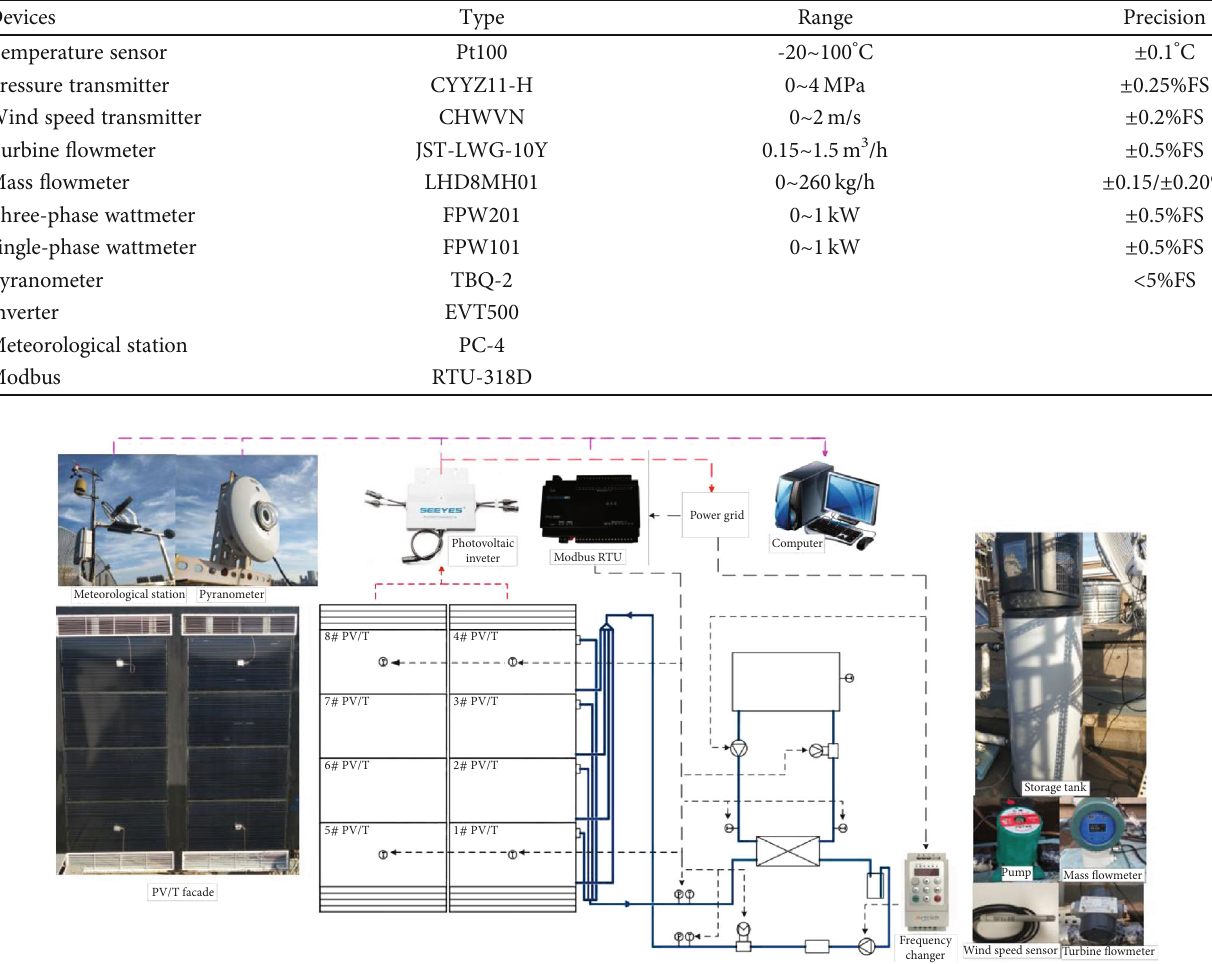
Figure 4: The proposed PV/T façade